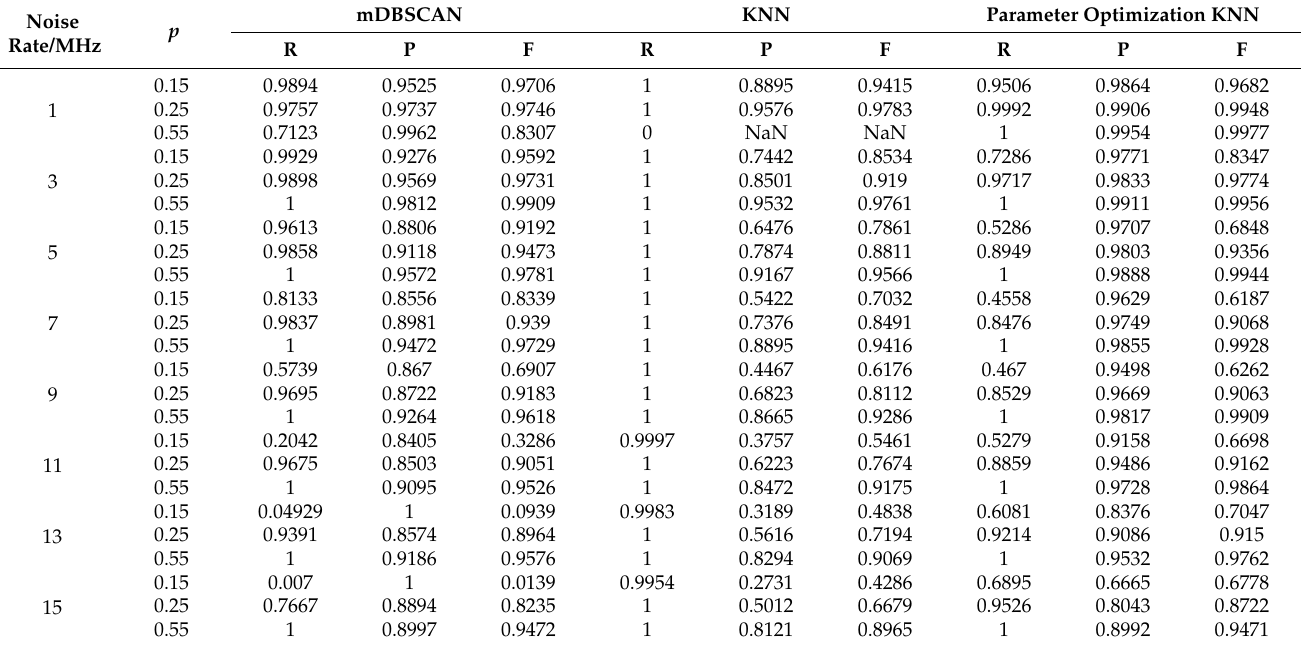
Table 1. Three statistical indicators of simulated data with three noise rates based on the modified DBSCAN algorithm, the original KNN algorithm, and the KNN after parameter